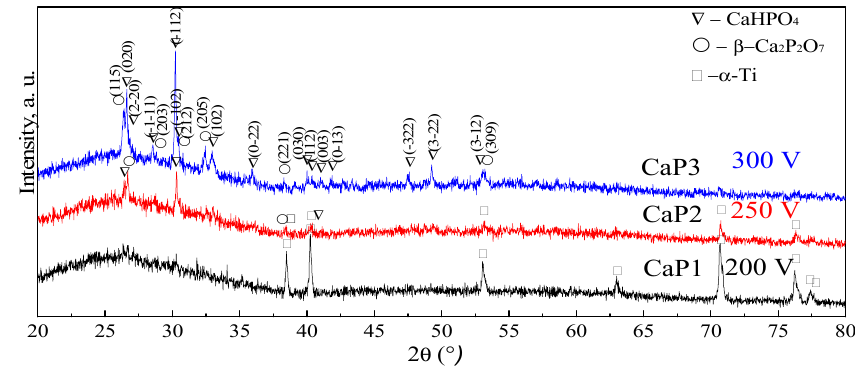
Figure 6. XRD patterns of the CaP coatings obtained at different process voltages ( V ).